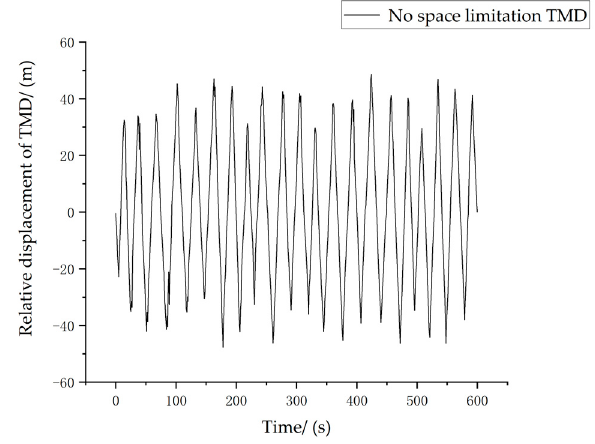
Figure 14. Relative displacement of TMD without stroke restriction.